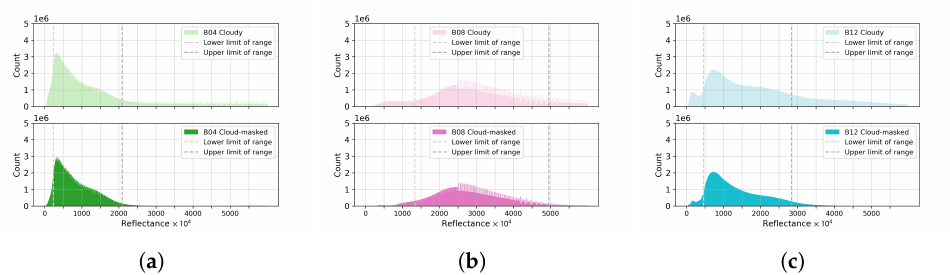
Figure 4. Displacement plots of surface reflectance histograms of three Sentinel-2 bands without cloud masking (top) and with cloud masking (bottom). The data is from the 11 May–31 August 2020. The range is set to [1, 6000]. The number of bins is 1000. ( a ) Band 4 (Red). ( b ) Band 8 (NIR). ( c ) Band 12